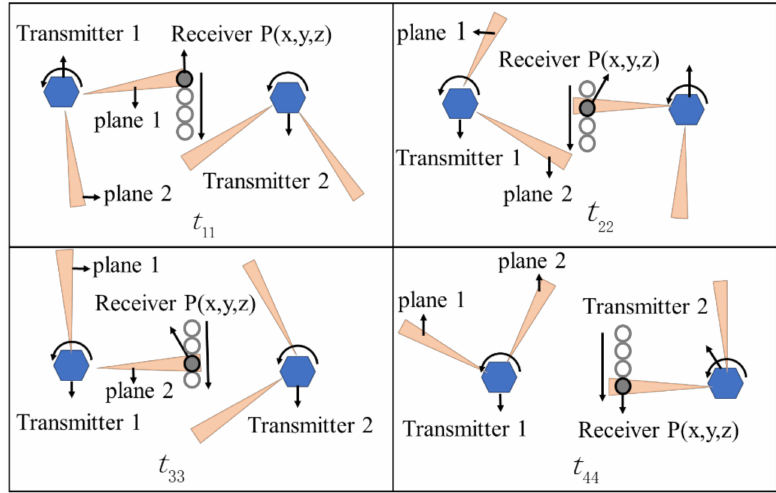
Figure 12. Effect of out-of-sync rotation of transmitting stations on the intersection relationship during dynamic state of the receiver. From left to right: the moment when the plane 1 of the transmitter 1 scans over the receiver; the moment when the plane 1 of the transmitter 2 scans over the receiver; the moment when the plane 2 of the transmitter 1 scans over the receiver; the moment when the plane 2 of the transmitter 2 scans over the receiver. It is obvious that the receiver in different position when the planes scans over the receiver separately, the angle-intersection conditions are destroyed, and the calculation accuracy of the receiver coordinates